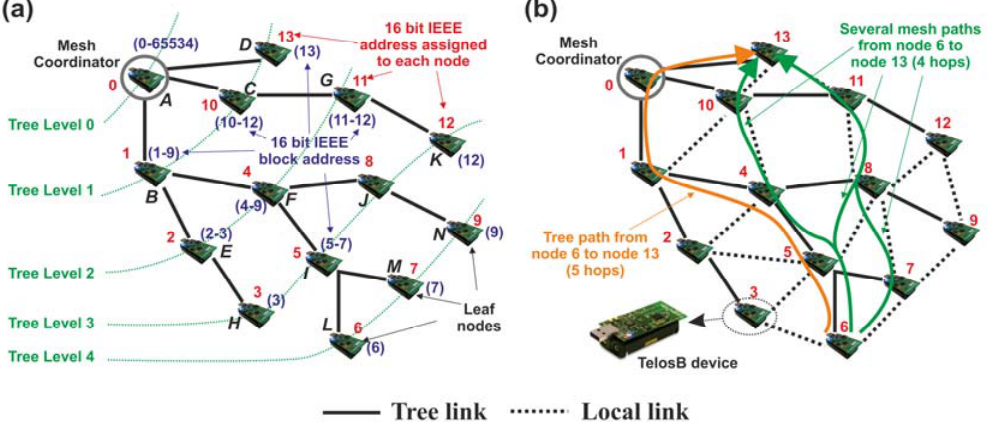
Figure 3. Example of an IEEE 802.15.5 mesh network consisting of 14 TelosB devices: ( a ) Tree formation (function 1) and addressing (function 2); ( b ) Local links generation (function 3) and unicast forwarding (function